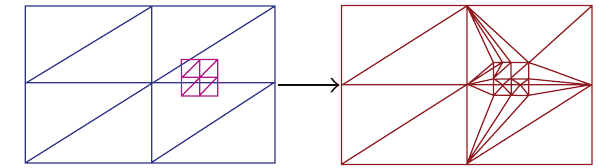
Figure 5: Stitching a plane over a bigger plane.